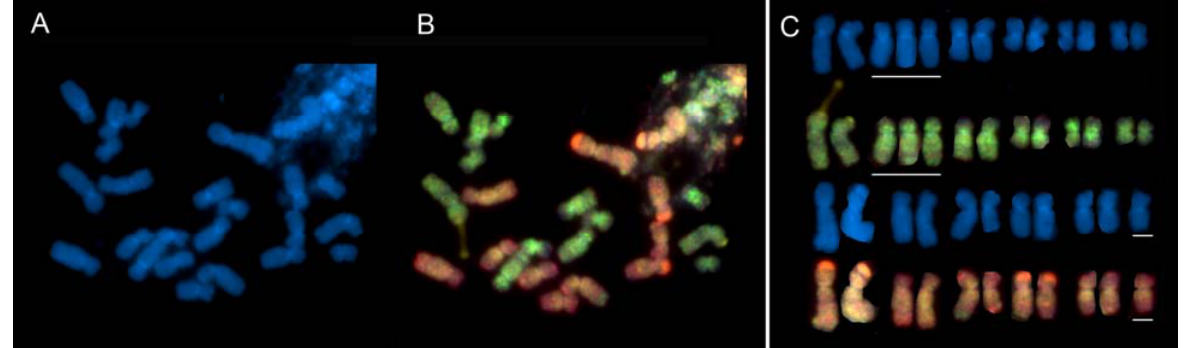
Figure 2. GISH to root tip metaphase chromosomes of a wild accession of Tragopogon mirus 2 n = 4 x = 24 -1 +1. (A) DAPI stained chromosomes. (B) Chromosomes hybridised with genomic DNA identifying subgenomes originating from either T. dubius (green) or T. porrifolius (red). (C) Karyotype with DAPI-stained chromosomes (from A) and genomic DNA hybridised chromosomes (from B) originating from T. dubius (top two rows) and T. porrifolius (lower two rows), respectively. White lines indicate trisomic and monosomic chromosomes,